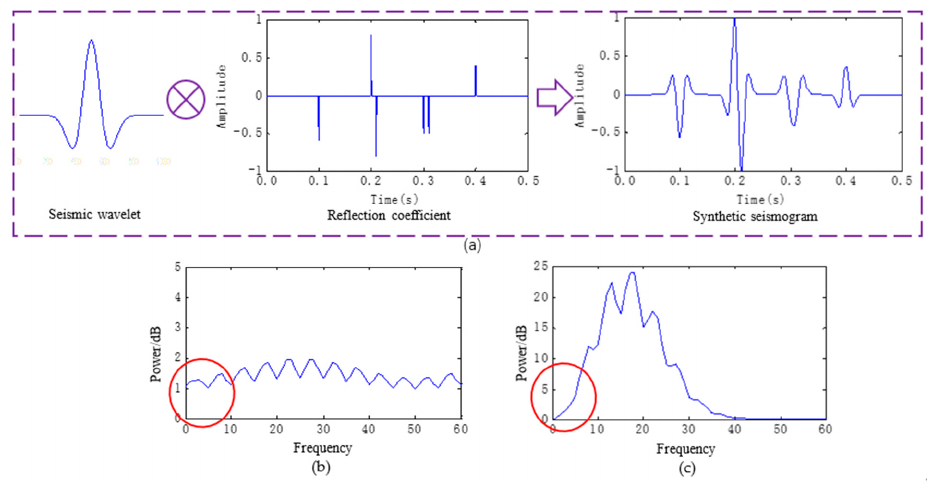
Figure 1. Schematic diagram of synthetic seismogram. ( a ) Convolution, ( b ) frequency spectrum of seismic reflection coefficient, ( c ) frequency spectrum of seismic